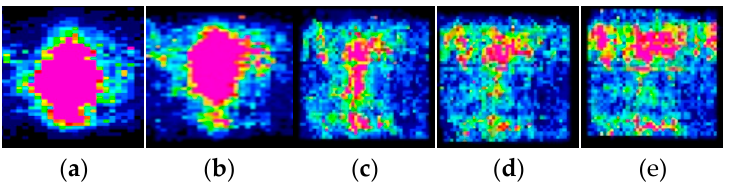
Figure 6. The distribution of contact stress distribution along with the change of the width and height of the thin plate: ( a ) aspect ratio of 18.75; ( b ) aspect ratio of 15; ( c ) aspect ratio of 9.375; ( d ) aspect ratio of 7.5; and ( e ) aspect ratio of 6.25.